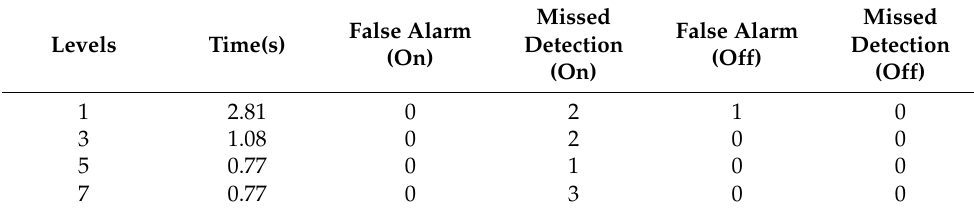
Table 5. Results based on different wavelet decomposition